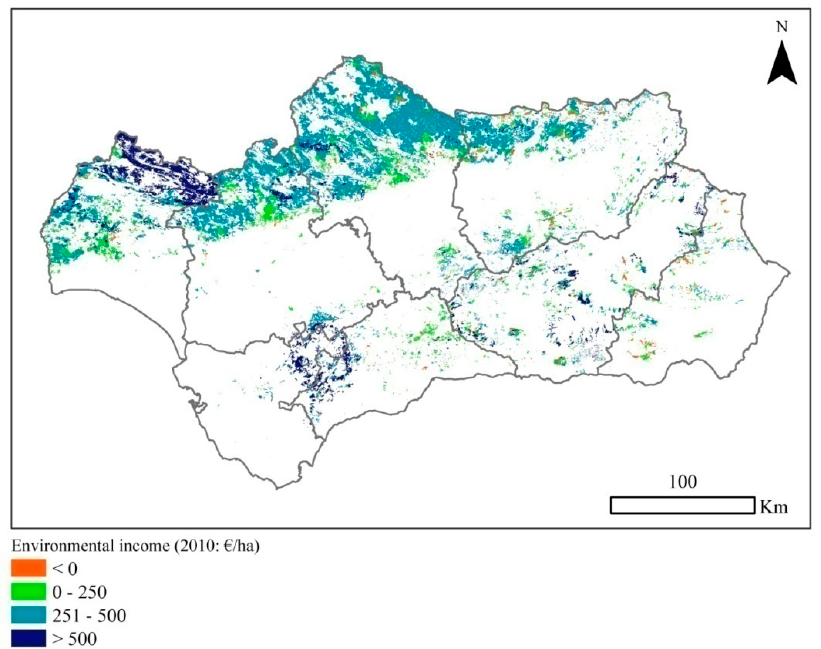
Figure 7. Agroforestry Accounting System total environmental income at producer prices for holm oak open woodlands in Andalusia. Source: Eloy Almazán based on the [24]. open woodlands in Andalusia. Source: Eloy Almaz á n based on the